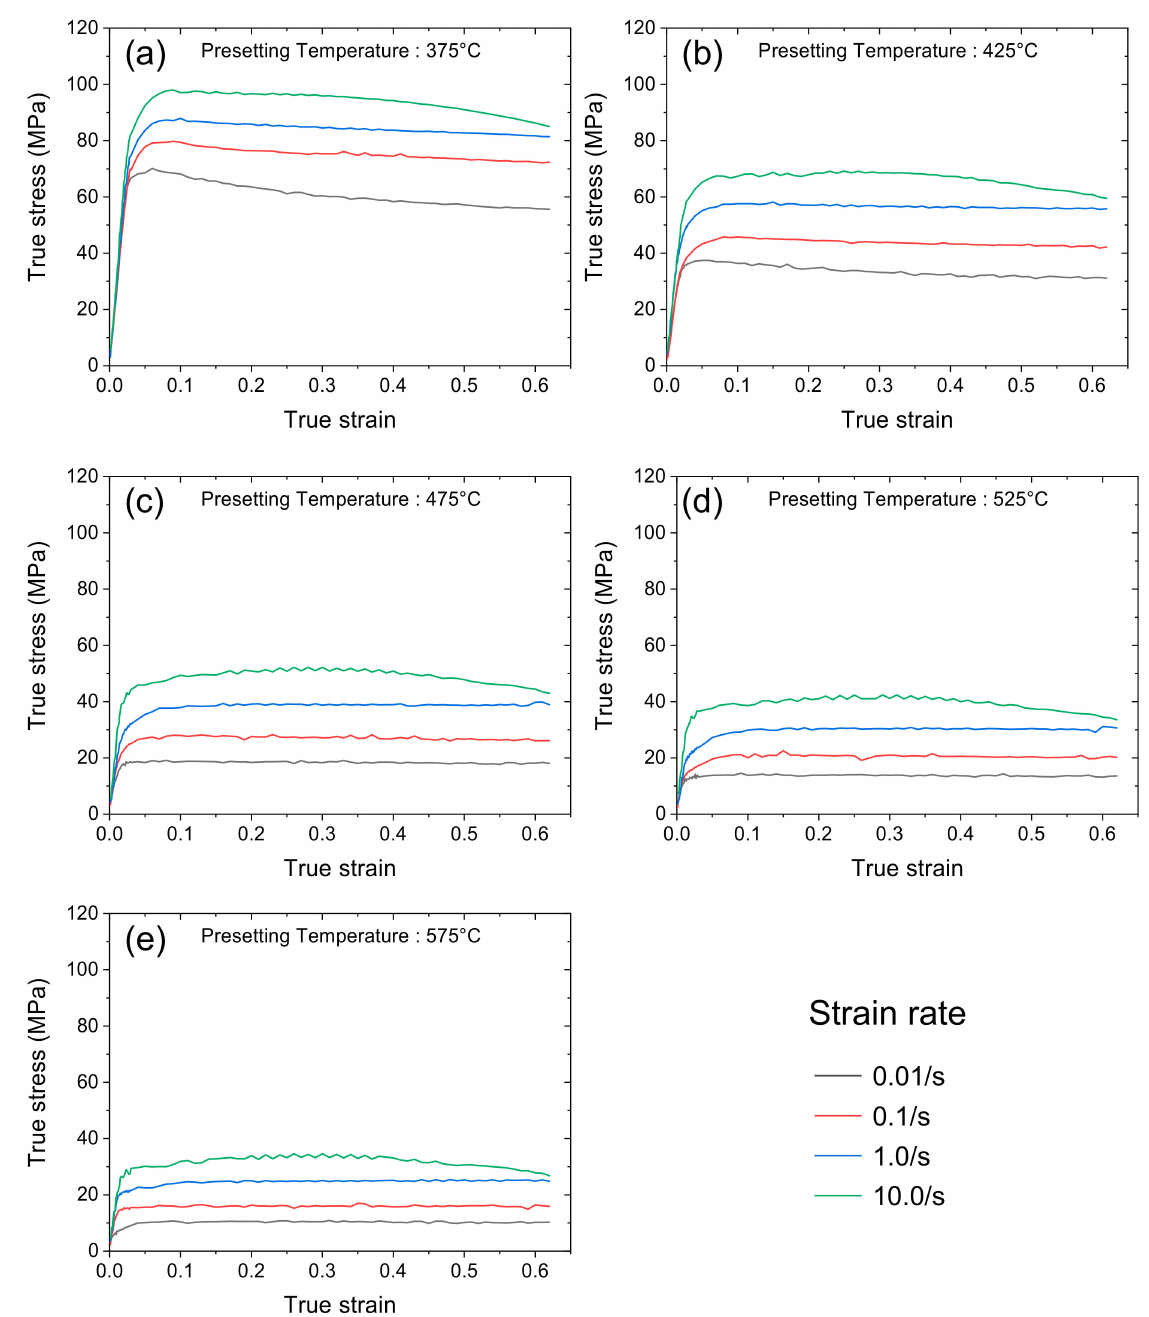
Figure 5. Measured stress–strain curves of AA6061 aluminum. The experiment data at different deformation conditions are grouped by the presetting temperature ( a ) 375 ◦ C, ( b ) 425 ◦ C, ( c ) 475 ◦ C, ( d ) 525 ◦ C and ( e ) 575 ◦